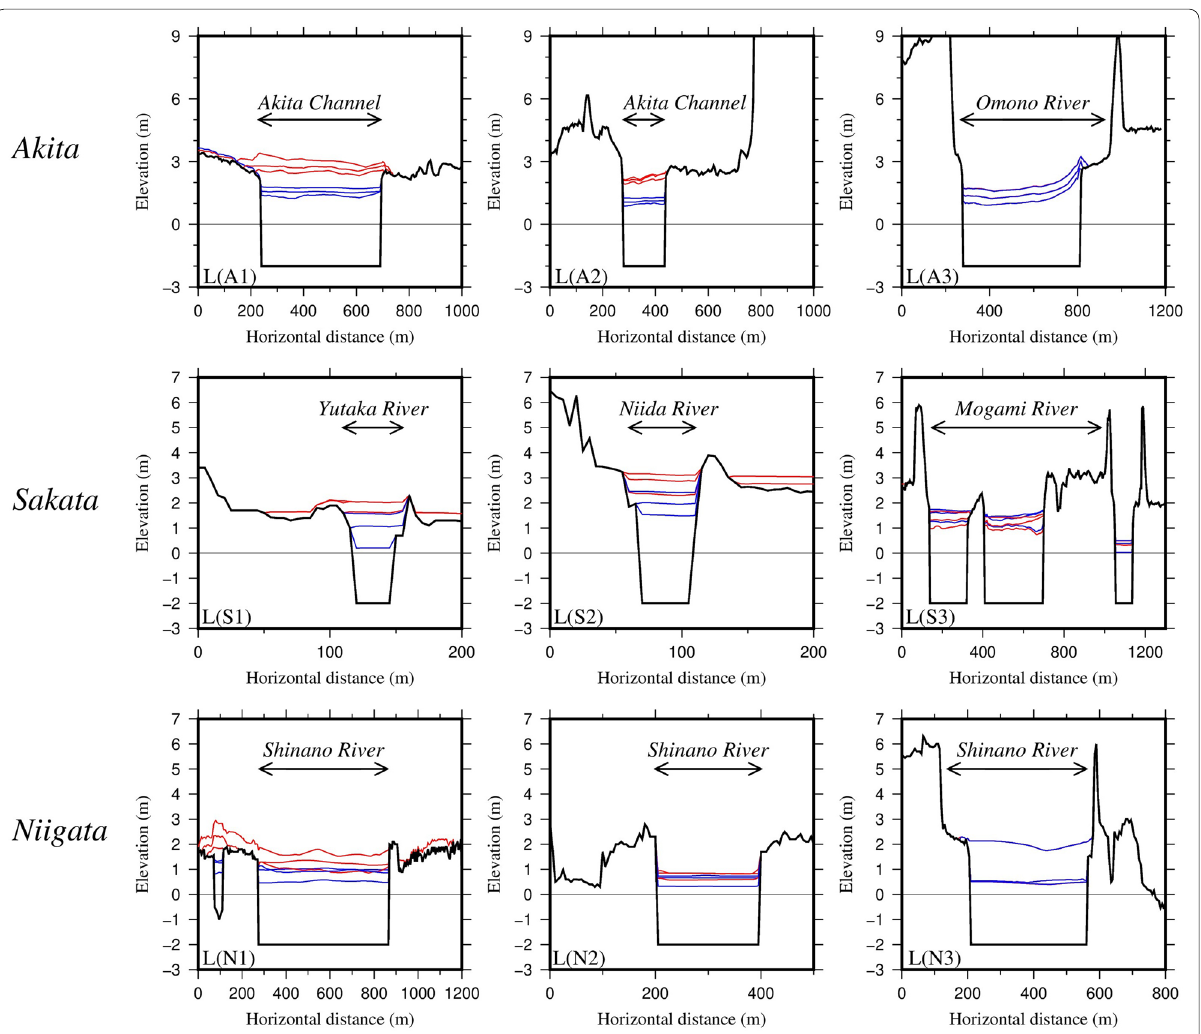
Fig. 13 Tsunami characteristics over the cross-sectional slices for rivers. Each line color in the panels indicates the profile of river channel (black) and the tsunamis in the three source scenarios for each area with the breakwaters (blue) and without